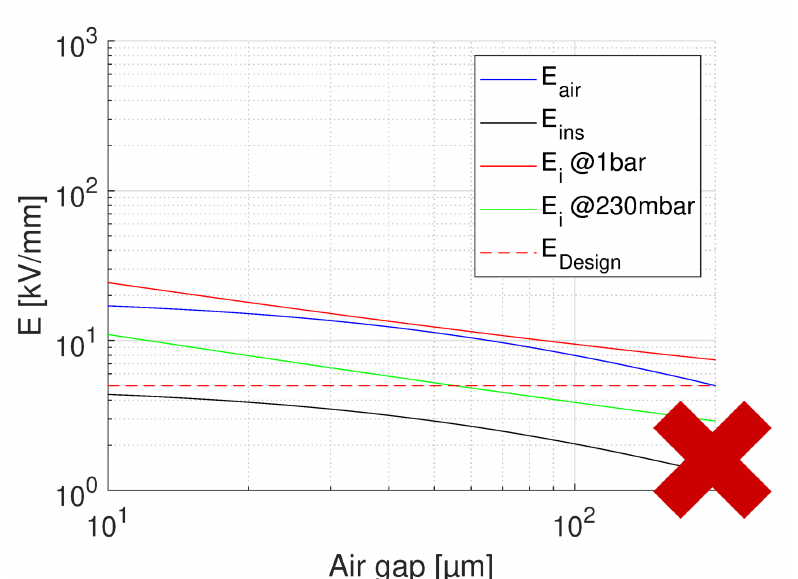
Figure 12. Feasibility plot for the optimum design of slot insulation, with the highest design field (5 kV/mm), and thinnest insulation (H2 = 200 µ m). Nominal operating voltage 1000 V (Figure 2, Table 1). The x axis reports the air gap thickness. No PD will be incepted in cavities of any size at